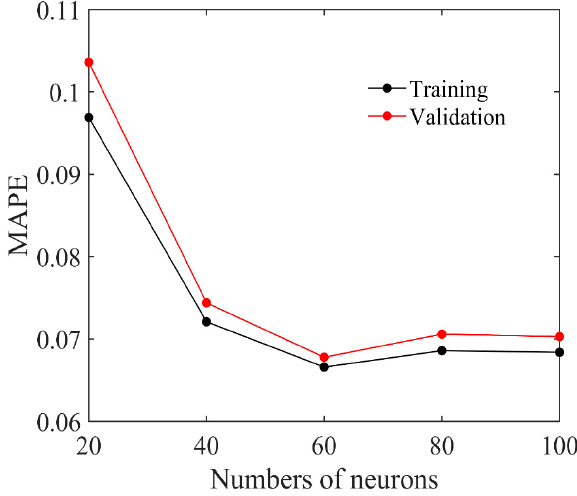
Figure 23. Errors in artificial neural networks with various hyperparameters.